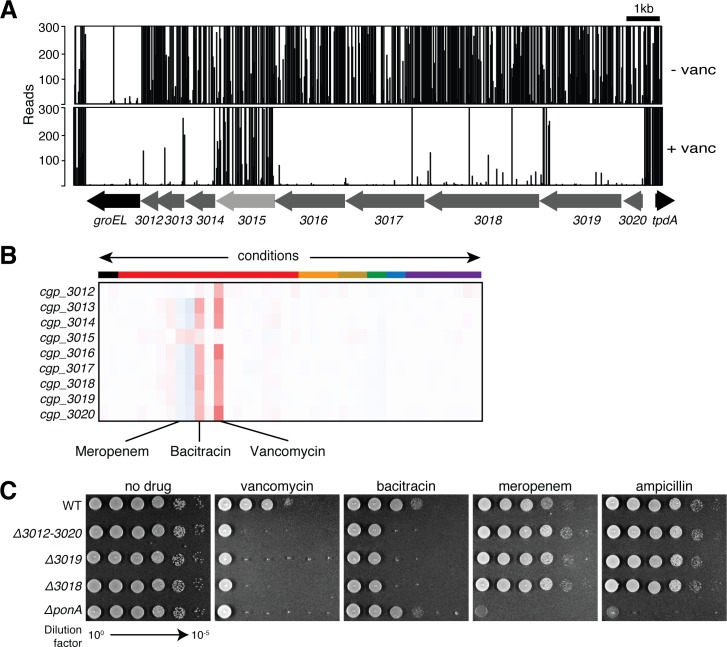
A genetic locus with a potential role in undecaprenol biogenesis or utilization.(A) Shown is the transposon insertion profile for the cgp_3012–3020 genomic locus for untreated (top, -vanc) and vancomycin-treated (+vanc, 0.4 µg/ml, bottom) samples. (B) Phenotypic profiles for all genes in the cgp_3012–3020 locus displayed as in Figure 2. (C) Cultures of wild-type Cglu and the indicated deletion mutants were normalized to an OD600 of 0.5 and serially diluted. An aliquot (5 µl) of each dilution was spotted onto BHI agar medium supplemented with drug as indicated. Drug concentrations used were 0.3 μg/mL vancomycin, 0.07 μg/mL bacitracin, 0.06 μg/mL meropenem and 0.2 μg/mL ampicillin. Plates were incubated for 24 hr at 30°C and photographed.